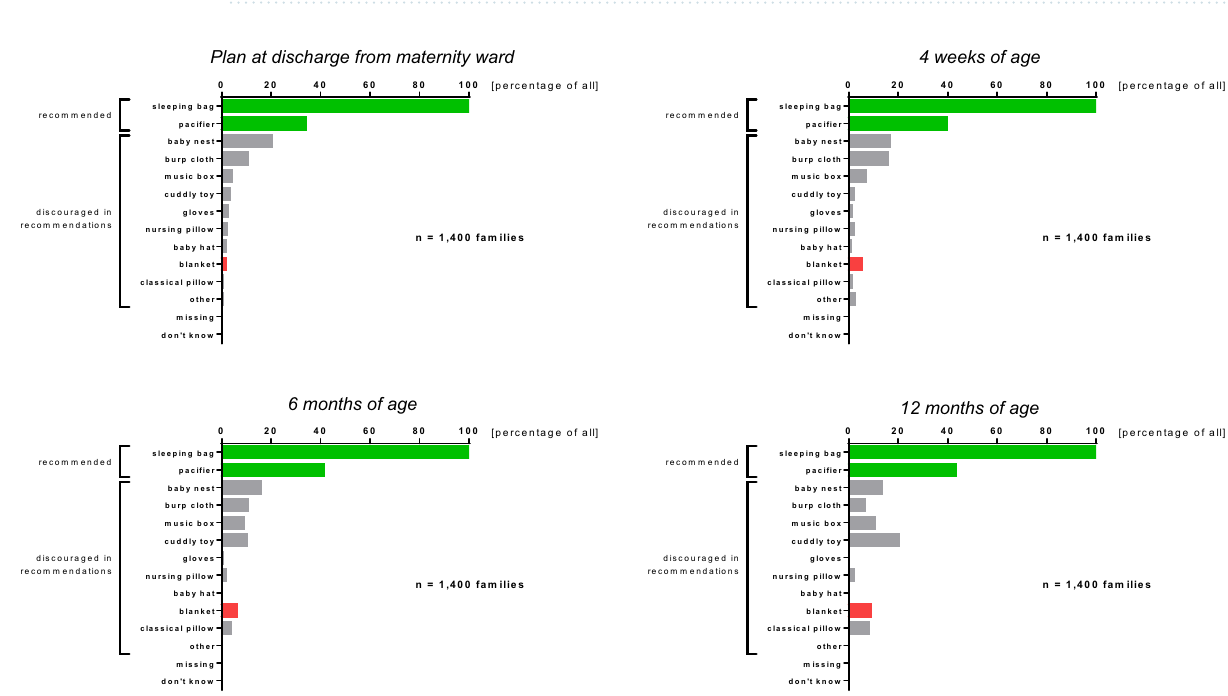
Figure 4. Frequency of prone positioning for sleeping (“ How often do you put your baby in the prone position ("face-down") for sleeping? ”).